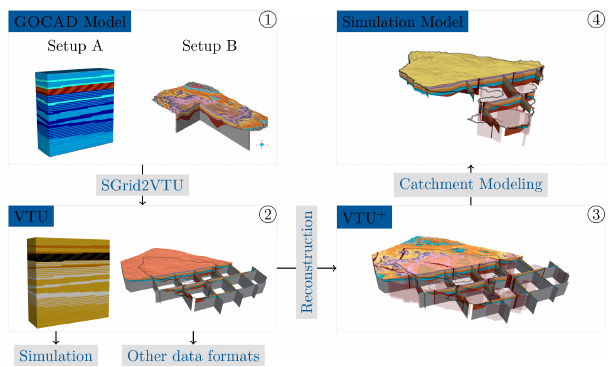
Figure 2. Workflow of GO2OGS for GOCAD to OGS mesh con- version; Setup A shows a model of different sedimentary layers; Setup B shows a model of the Thuringian Syncline (legend given in Fig. 3); see Sect. 1.2 for a description of the setups.